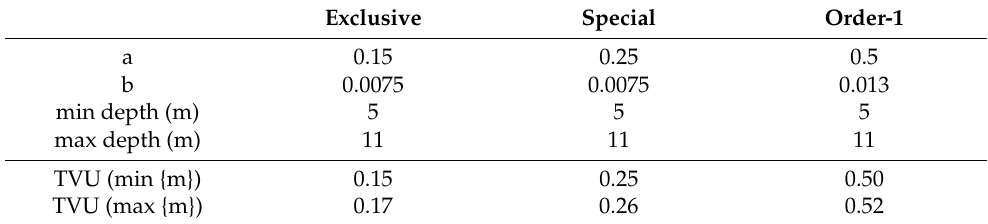
Table 5. IHO’s minimum bathymetry standard for Exclusive, Special, and Order-1 hydro- graphic